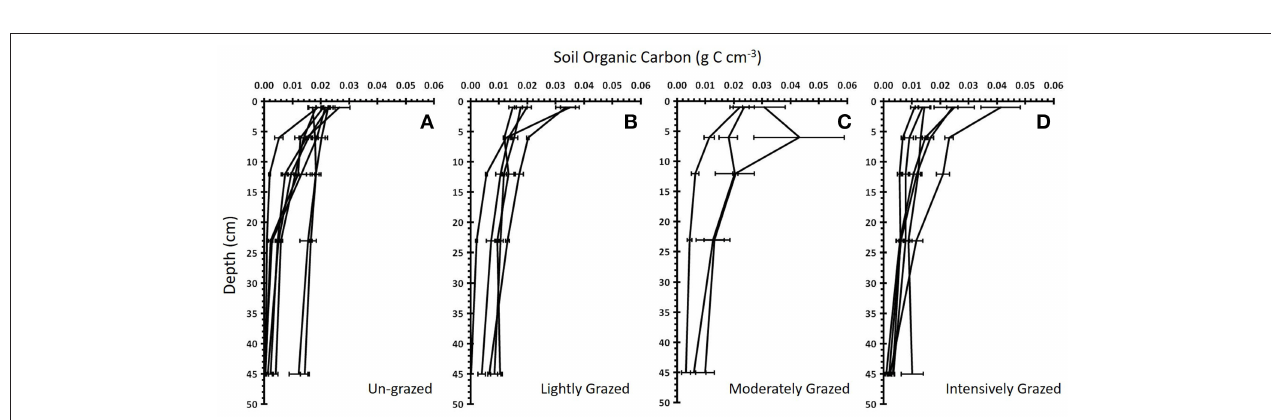
FIGURE 3 | Soil organic carbon density vs. grazing intensity by zone for each of the depths analyzed. Results of the regression analysis showing the relationship between soil organic carbon density and grazing intensity (stocking density, LSU ha − 1 ) for each zone and for each of the depth profiles analyzed: top 2cm, top 10cm, and top 50cm. With the false discovery rate corrections ( Verhoeven et al., 2004), there were no significant impacts of grazing on soil carbon ( Supplementary Information S1 : regression table).